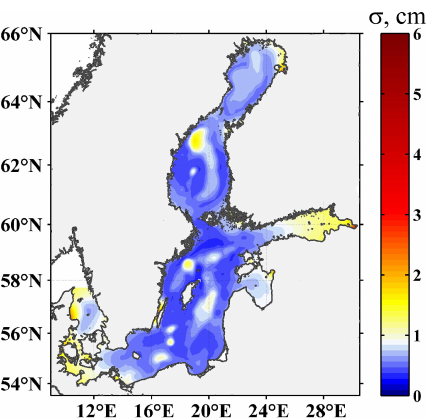
Figure 5. Sea level standard deviation ( σ ) for free barotropic oscil- lations simulated by